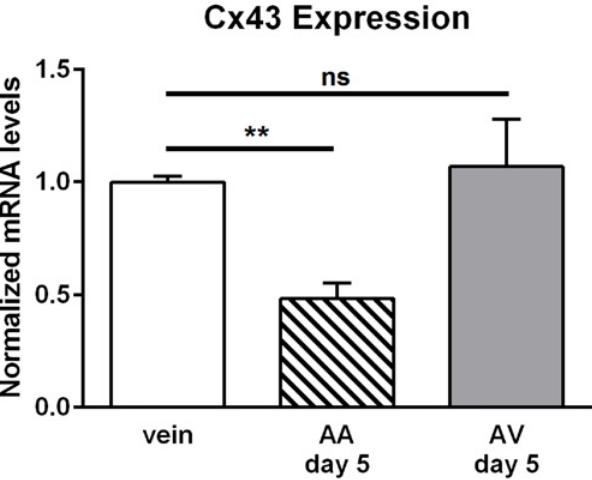
Fig 7. Expression of connexin43 (Cx43) at the mRNA level. Expression of Cx43 was quantified at the mRNA level in explanted loops (AA n = 3; AV n = 4) and in veins that were dissected and reintegrated into the venous limb circulation using quantitative PCR. Values in untreated veins (vein, n = 3) are taken as 1 after normalization to the expression level of GAPDH. At day 5 after implantation, Cx43 gene expression was reduced in AA, but not in AV loops compared to sham treated veins. All values are mean ± SEM, ** P < 0.01 unpaired t test, Bonferroni